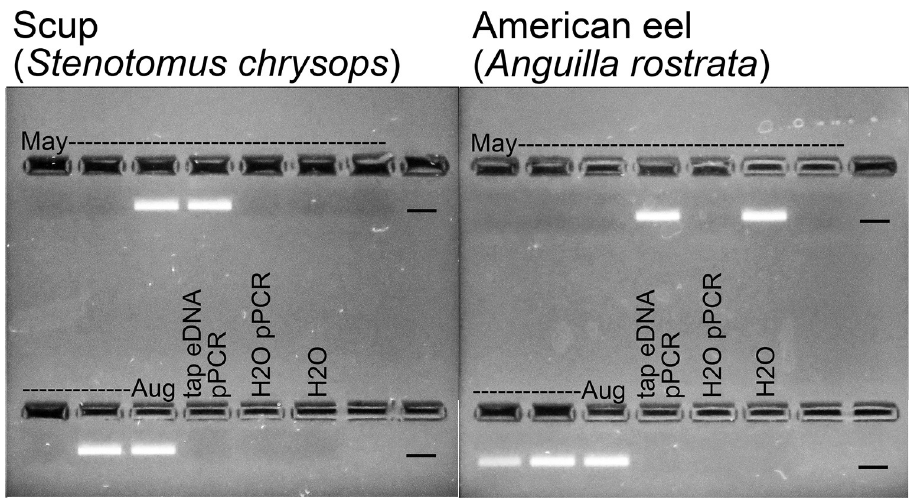
Fig 2. Representative GoFish amplifications visualized on 2.5% agarose gel with SYBER Safe. Lanes bracketed by dates are time series samples from East River site; the last three lanes in each panel are negative controls detailed in Materials and Methods. Marker indicates dye front at approximately 150 bp. Gel positives were sent for Sanger sequencing to confirm target species amplification.